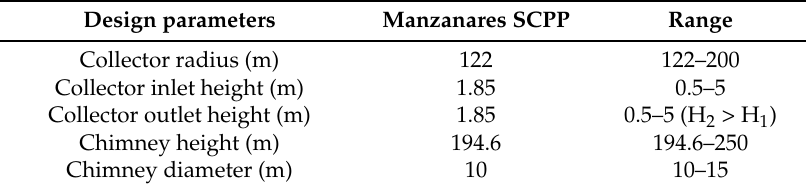
Table 3. Design parameters for Manzanares power plant and their acceptable ranges.